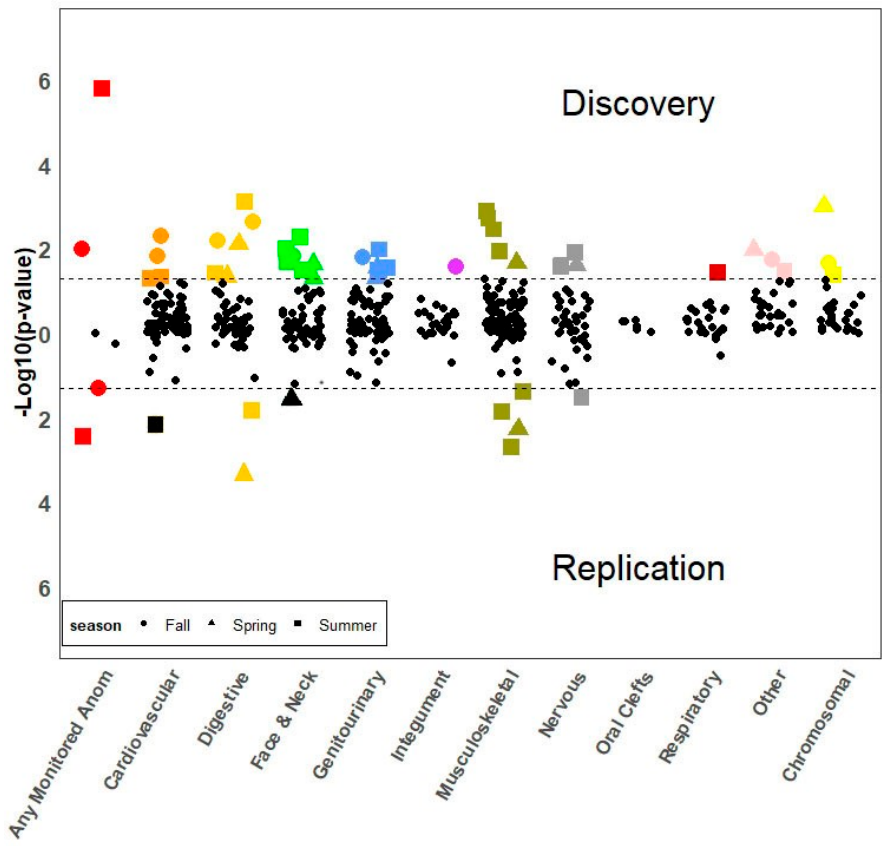
Figure 3. Associations between season of conception and birth defects. Birth defects associated with season of conception at p < 0.05 in discovery (upper panel) ( n = 35) were re-tested in replication (lower panel). Those associated with season of conception in replication with the same direction of effect and at p < 0.05 were declared significant ( n = 7 unique birth defects and 9 season-birth defect associations).